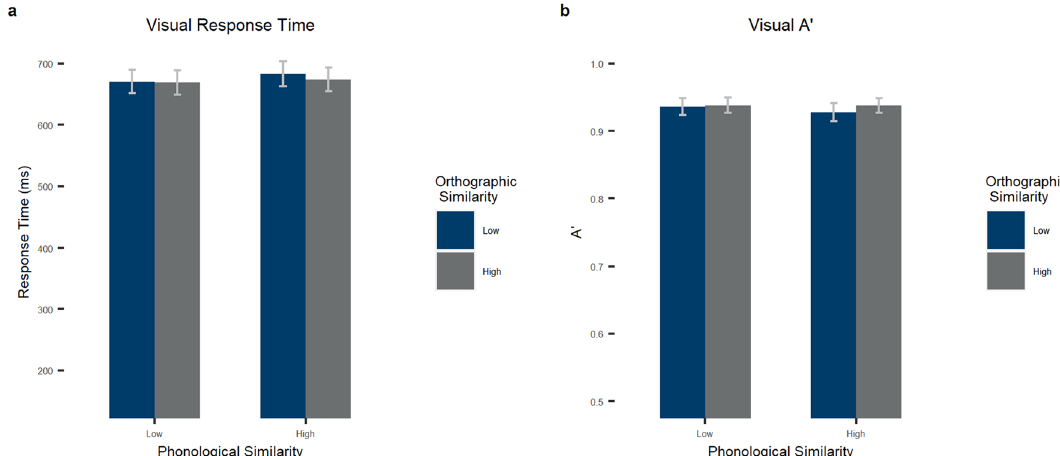
Figure 4. Results for the lexical decision task in the visual modality. ( a ) Response times in miliseconds and ( b ) A’ by phonological (bar clusters) and orthographic (bar color) similarity for the visual task. Error bars stand for 95% confidence intervals.